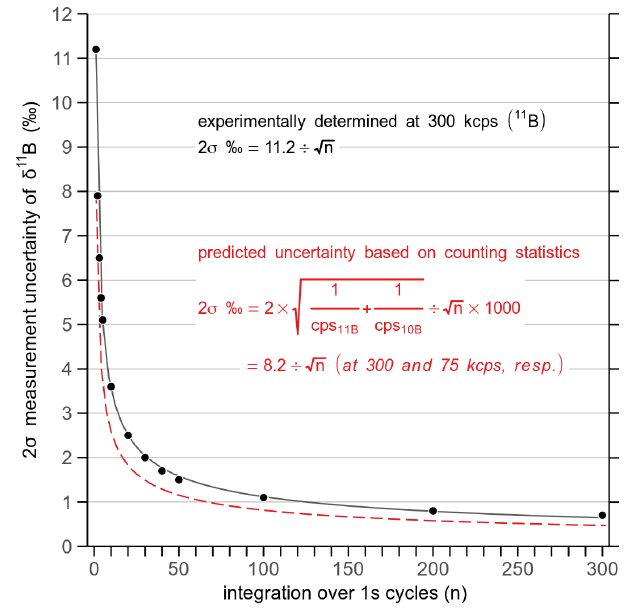
Figure 3. Measurement uncertainty of 11 B / 10 B (2 σ ) at count rates of 300000cps ( 11 B) as a function of the laser ablation time. The uncertainty of each boron isotope measurement is calculated based on this relationship (black solid line). A major portion ( ∼ 70%) of the measurement uncertainty is related to Poisson-distributed counts (red dashed